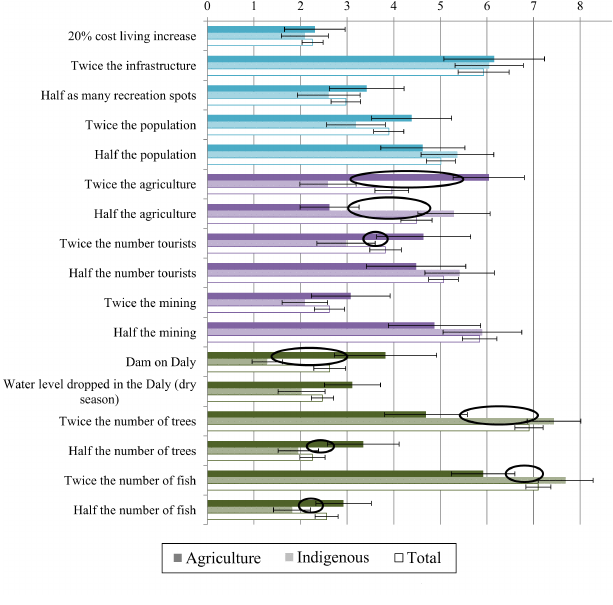
Fig. 5 . Mean satisfaction (0 being much more dissatisfied and 9 being much more satisfied) and confidence intervals for hypothetical changes in the catchment for three groups of respondents: those who earn income from agriculture, indigenous respondents, and total respondents. Changes to daily life (blue) covered cost of living, infrastructure, recreation spots, and population. Economic changes (purple) concerned changes in agriculture, tourism, and mining. Environmental changes (green) were a dam on the Daly, reduction in dry- season water level in the Daly, abundance of trees, and abundance of fish. Agricultural respondents are shown by solid color, indigenous respondents with diagonal hatching, and total respondents with white bars. Significant differences between agricultural and indigenous respondents are